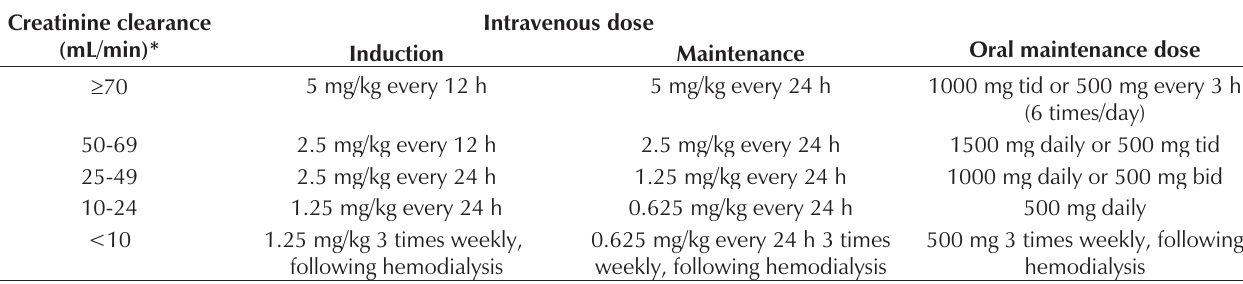
Ganciclovir dosing guidelines for renal